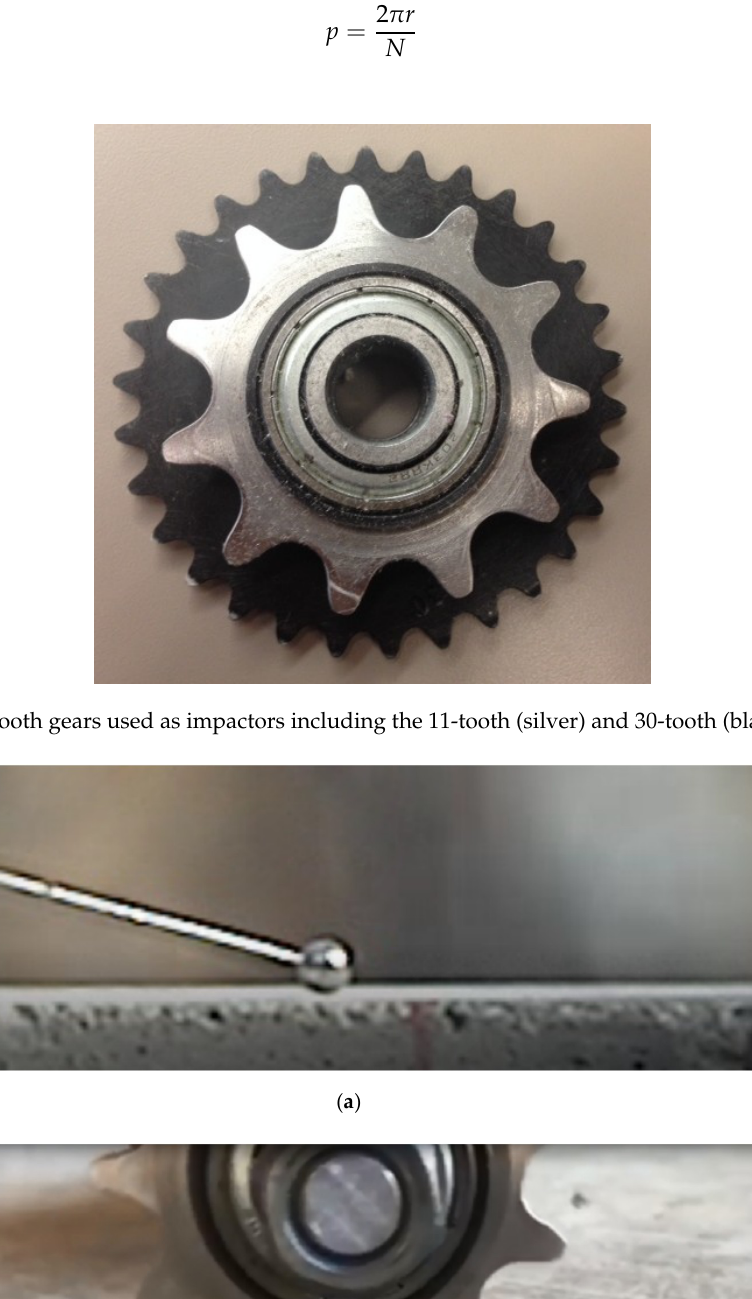
Figure 4. Designed IE system including tooth gear and microelectromechanical systems (MEMS). Figure 5. Data acquisition and experimental set-up for the IE system.